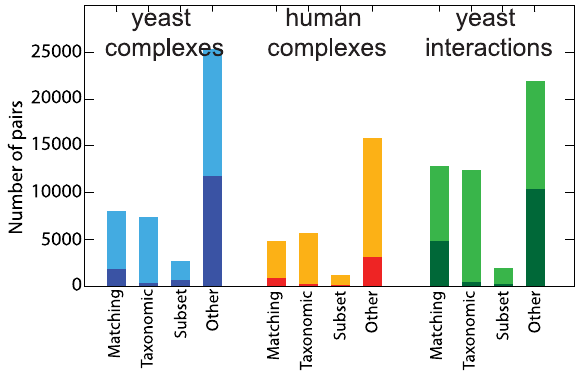
Figure 4. Distribution of profile-pair types among co-complex proteins and yeast interactions. The pairs are divided into the the same categories as in the pie charts of Figure 2. The dark part of each bar corresponds to the number of co-complex protein pairs or yeast interactions that are part of a positive-scoring triplet.